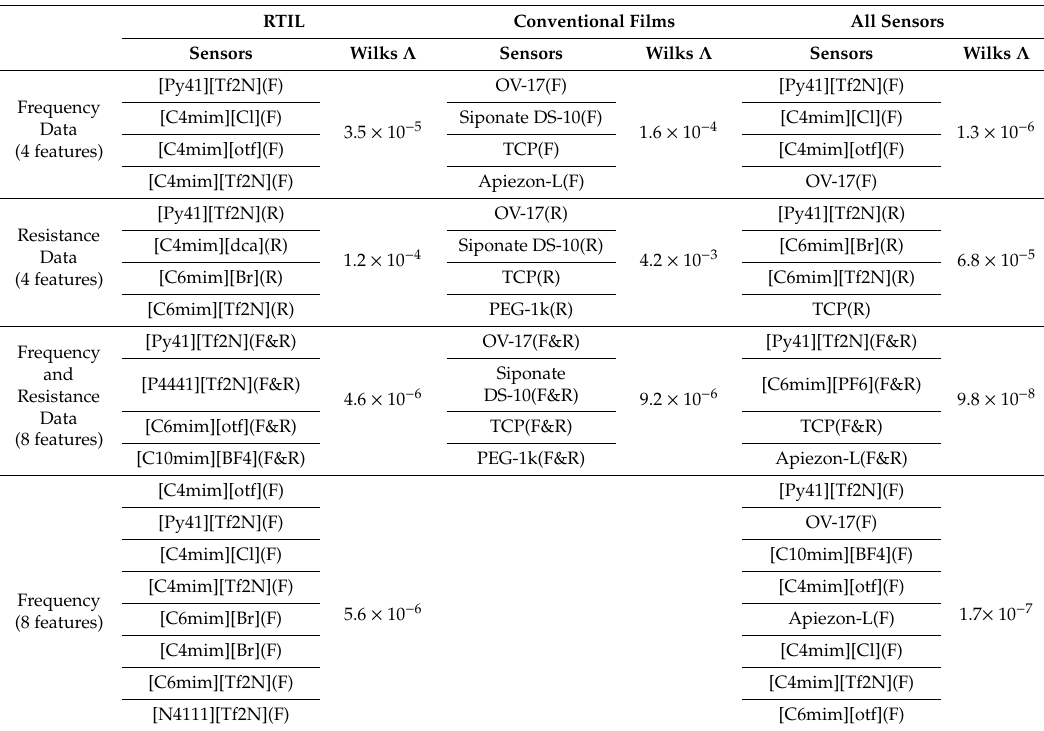
Figure 3. LDA of array of four best conventional films using frequency (F) and resistance (R) data. Table 3. Wilks lambda and the best sensor selection of di ff erent number of sensor taken from di ff erent sets (first column: RTIL, second column: conventional films, and third column: all sensors). (F) refers to frequency data and (R) refers to resistance